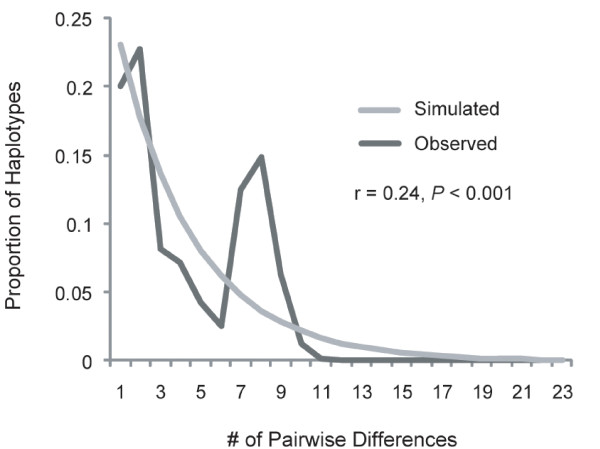
Mismatch distribution for Cephalopholis argus. Mismatch distribution based on 550 cytochrome b sequences from twenty-one populations. The dark colored line represents the observed and light colored line is the simulated pairwise differences as reported by DnaSP 5.0 [39]. The Harpending's raggedness index as calculated in ARLEQUIN 3.5 [42] and corresponding P-value are shown.